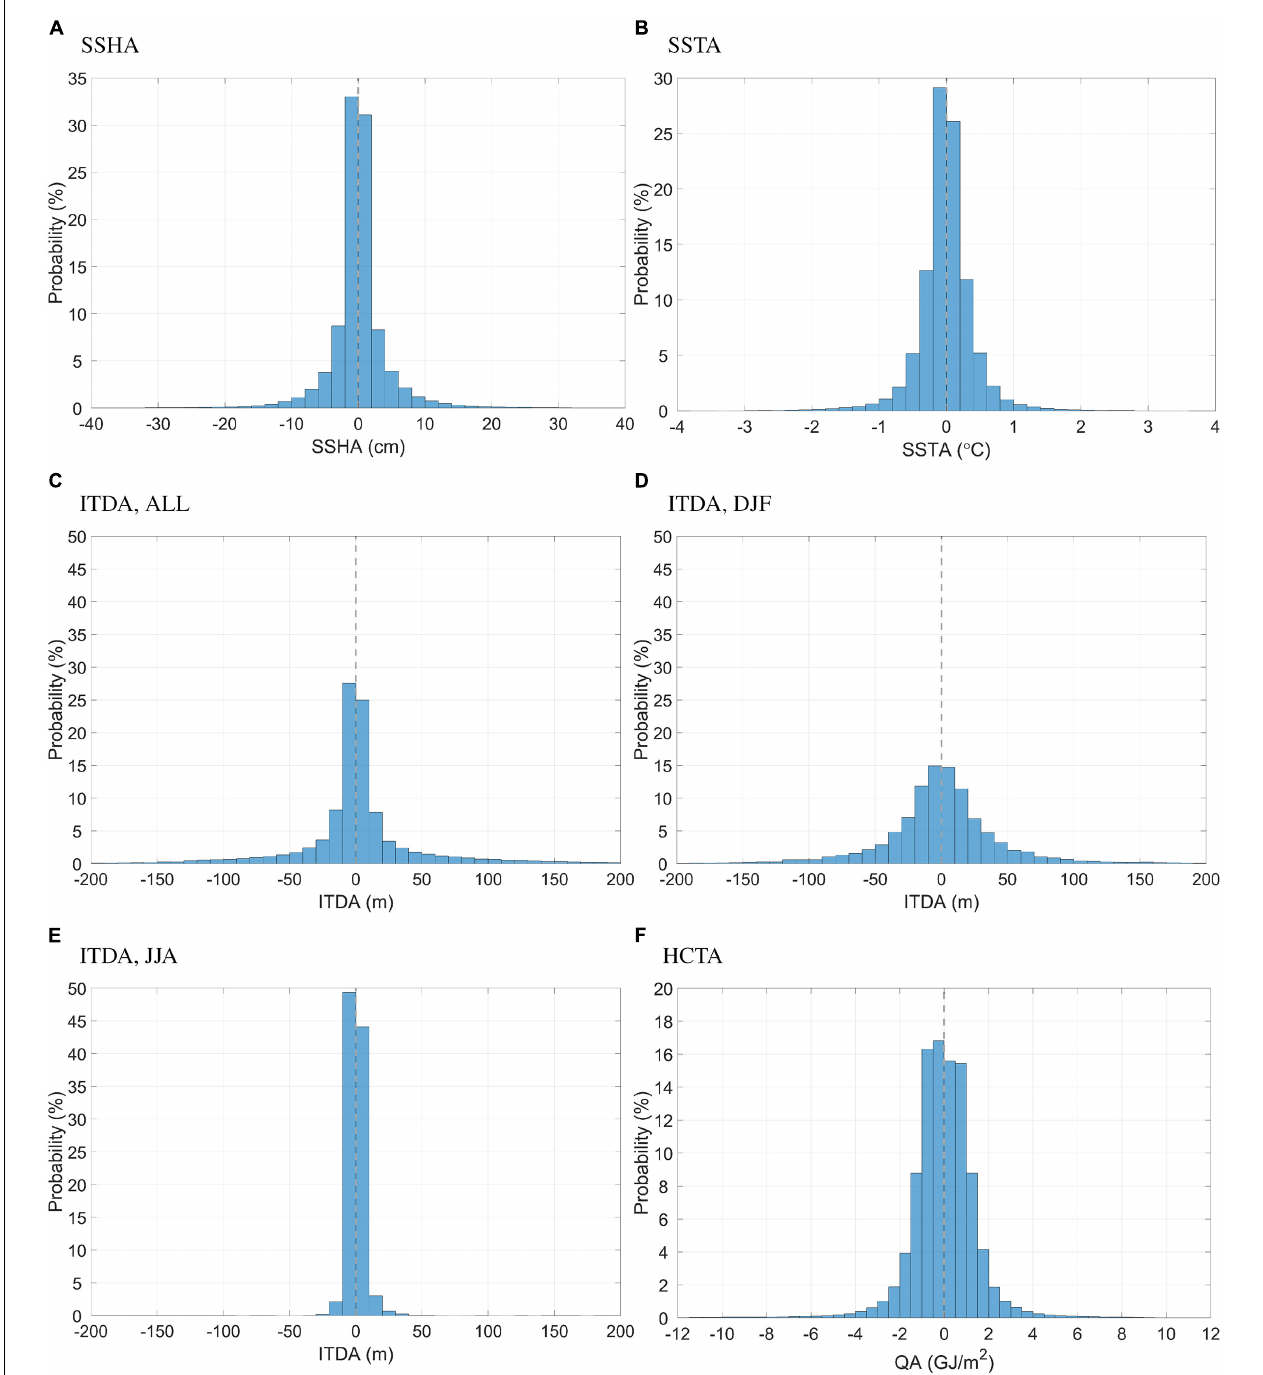
FIGURE 6 | Histograms of eddy-induced (A) SSHA (cm), (B) SSTA ( ◦ C), (C) overall ITDA (m), (D) ITDA in winter (DJF, m), (E) ITDA in summer (JJA, m), (F) HCTA (GJ/m 2 ).